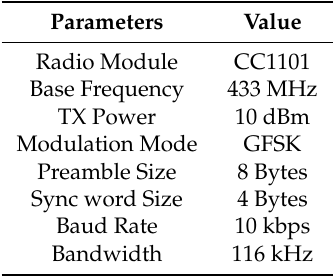
Table 1. RF module